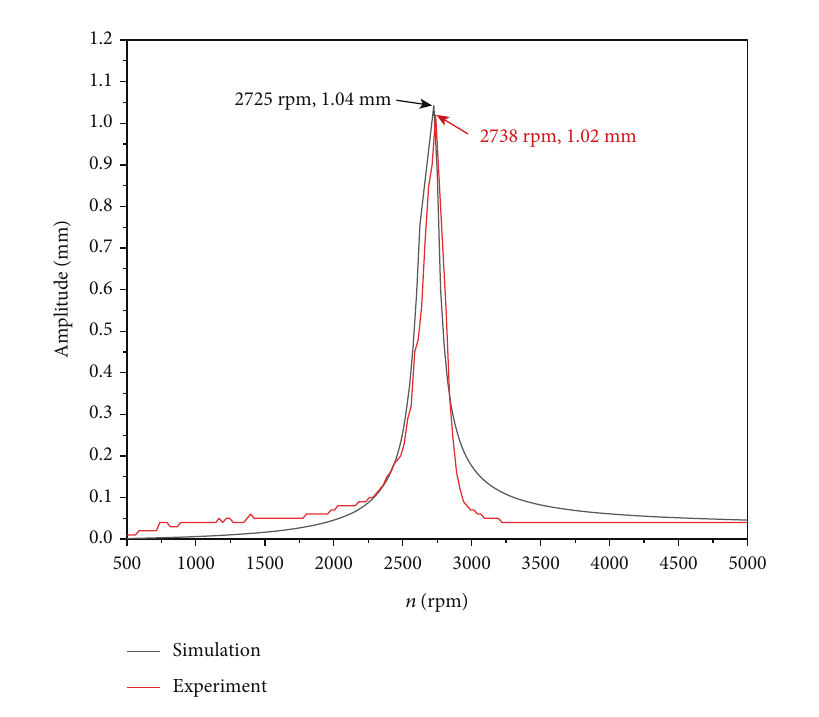
Figure 13: Transient response of the rotor